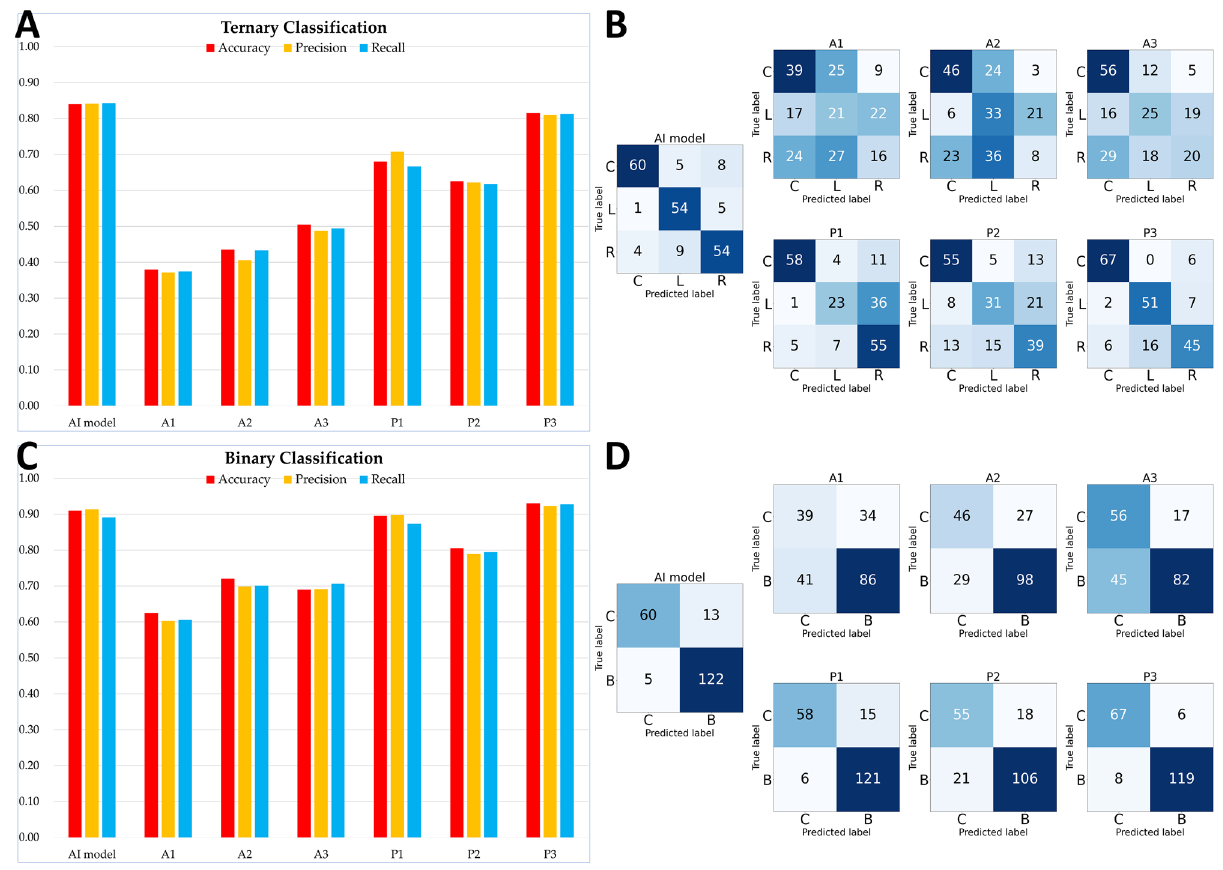
Figure 5. Performance metrics of the artificial intelligence model and human experts. ( A ) Classification metrics for ternary (carina/left main bronchus/right main bronchus); ( B ) confusion matrix for ternary classification; ( C ) classification metrics for binary (carina/both main bronchi); ( D ) confusion matrix for binary classification. A1, A2, and A3 are anesthesiologists with 1, 15, and 24 years of specialist experience and P1, P2, and P3 are pulmonologists with 12, 14, and 20 years, respectively, of specialist experience working in a referral university hospital. Letters C, L, R, and B in the confusion matrix indicate the carina, left main bronchus, right main bronchus, and both main bronchi,